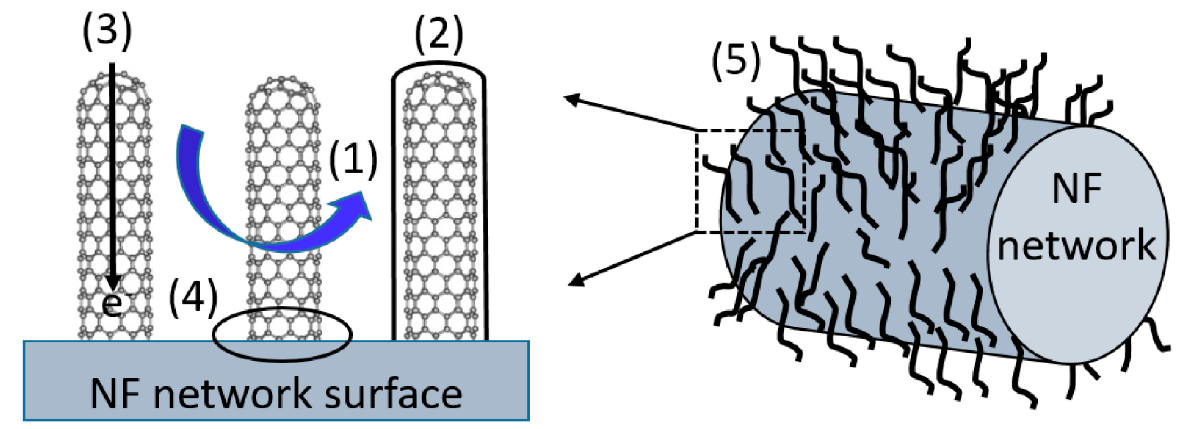
Figure 7. Illustration of advantages of the direct growing of CNTs on the NF collector.